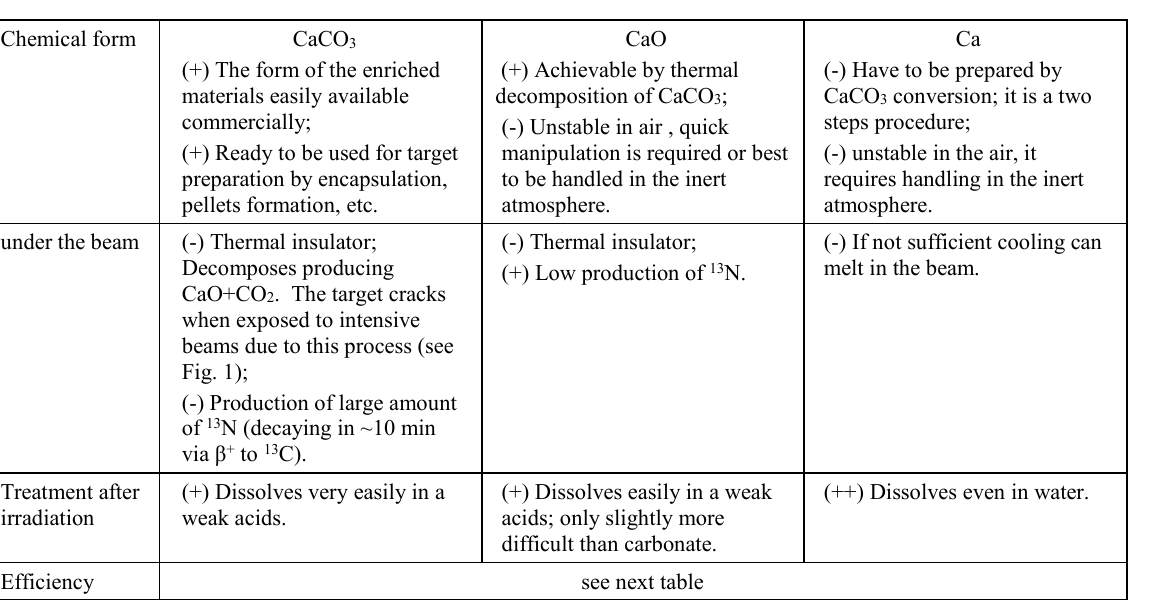
Table 2. Advantages (+) and drawbacks (-) of use of various chemical form of calcium targets .